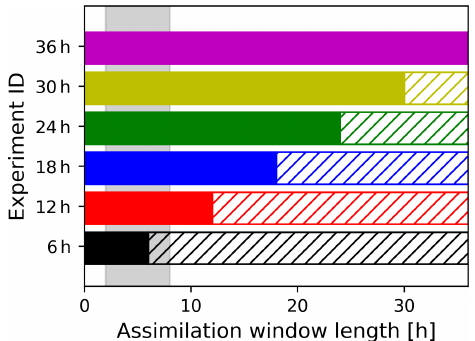
Figure 3. Illustration of the varying assimilation window lengths for the identical-twin experiment (filled bars). After each assimilation window, a free forecast until 36h after the start of the simulation is appended (hatched bars). Color codes and experiment IDs corre- spond to the annotations in the subsequent figures. The gray back- ground area indicates the duration of the volcanic eruption from hours 2 to